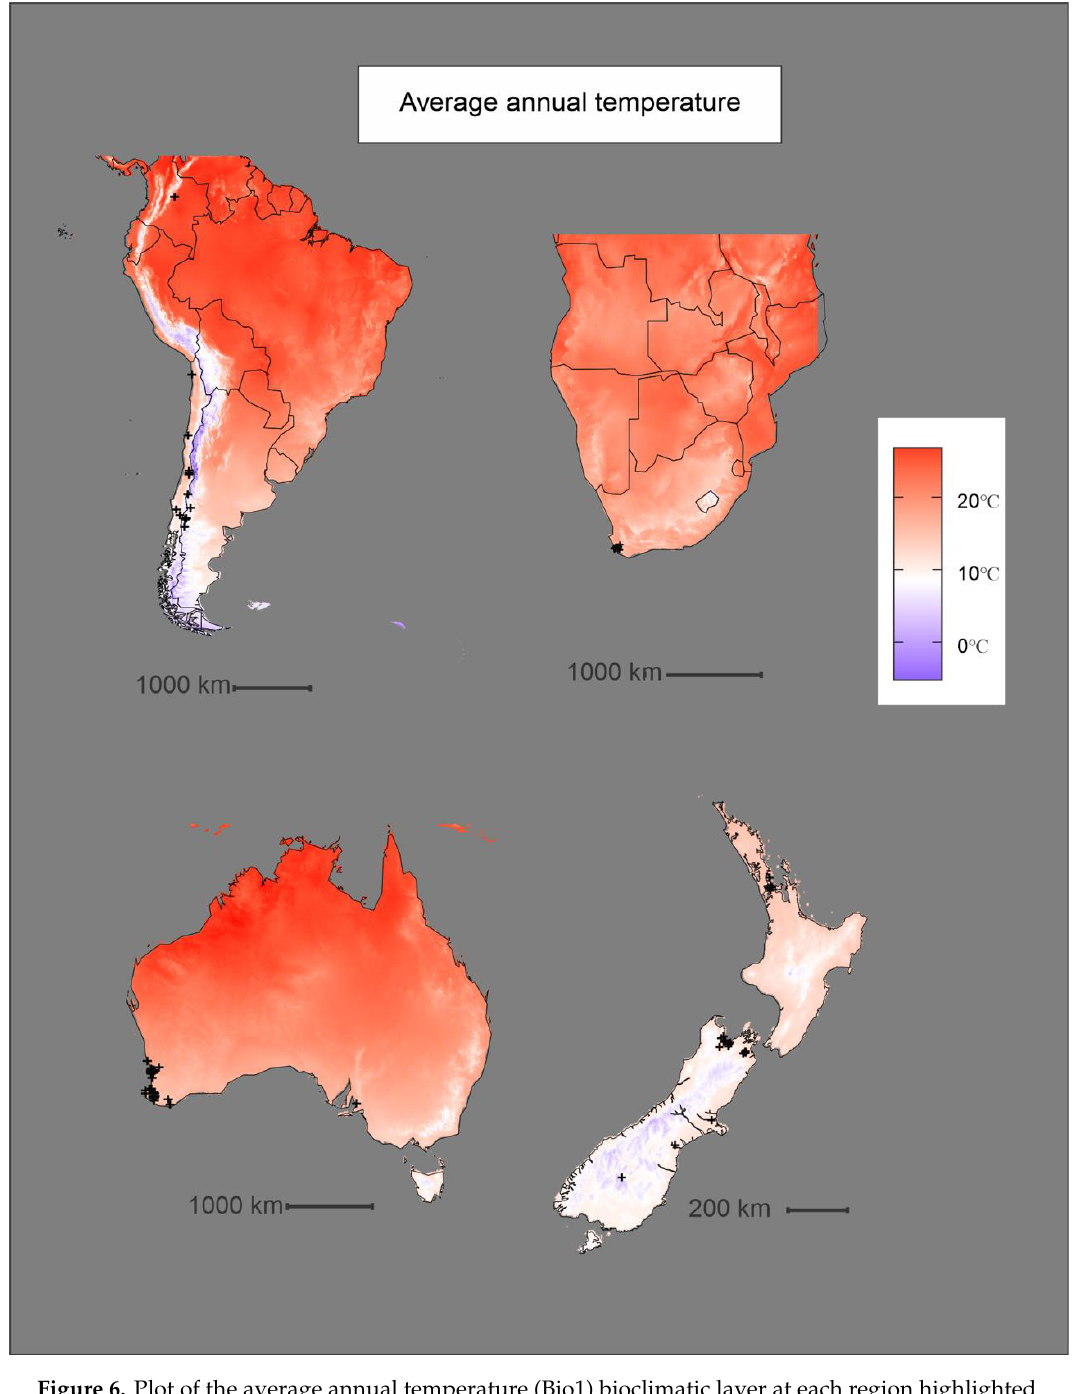
Figure 6. Plot of the average annual temperature (Bio1) bioclimatic layer at each region highlighted in this study. This variable had the highest permutation importance of 37.9%. Black crosses indicate known occurrences of P. dominula.